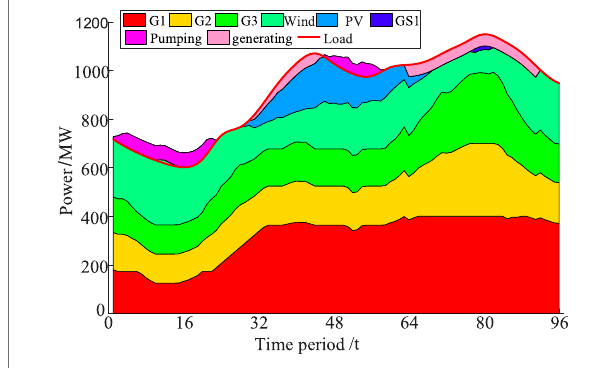
FIGURE 8 | Unit output curves of Case 3.